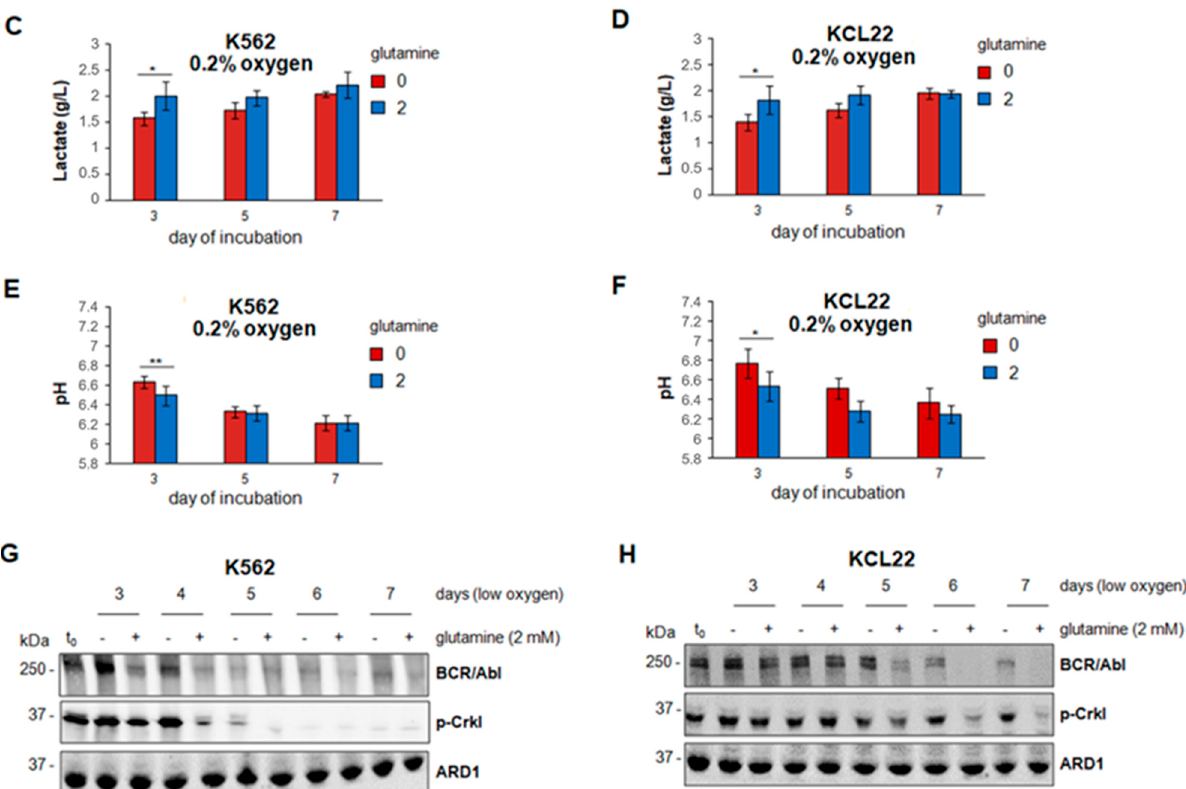
Figure 2. Effects of the lack of glutamine on glucose consumption, lactate production, pH reduction and BCR/Abl expres- sion/signaling in low oxygen. K562 ( A , C , E , G ) or KCL22 ( B , D , F , H ) cells were seeded at 3 × 10 5 cells/mL and incubated in atmosphere at 0.2% O 2 for the indicated times in the absence (0/ − ) or the presence (2/+) of 2 mM glutamine from time 0 (t0) of incubation. ( A – F ) Glucose and lactate concentrations and pH were measured in culture medium. Values are mean ± S.D. of data obtained from 3 independent experiments; 0 vs. 2 mM glutamine: * p < 0.05, ** p < 0.01. Horizontal bars indicate the t0 values. ( G , H ) Total cell lysates in Laemmli buffer were obtained at the indicated times of incubation and subjected to SDS-PAGE and immuno-blotting with anti-Abl or anti-p-Crkl Ab; anti-ARD1 Ab was used to verify the equalization of protein loading. One representative experiment out of 3 with similar results is shown. The original Western blotting im- ages and the relative densitometry values can be found in Supplementary Figure S1.